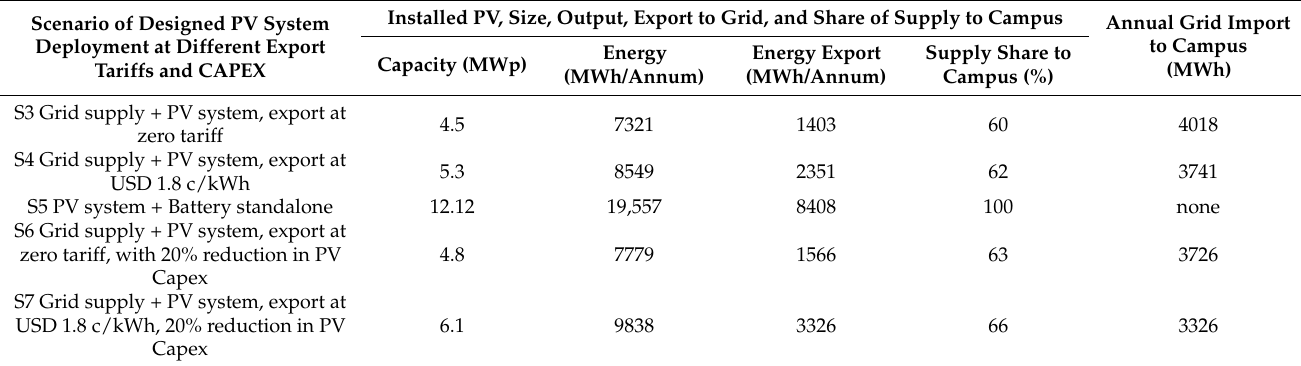
Table 3. PV capacity and electricity supply under different